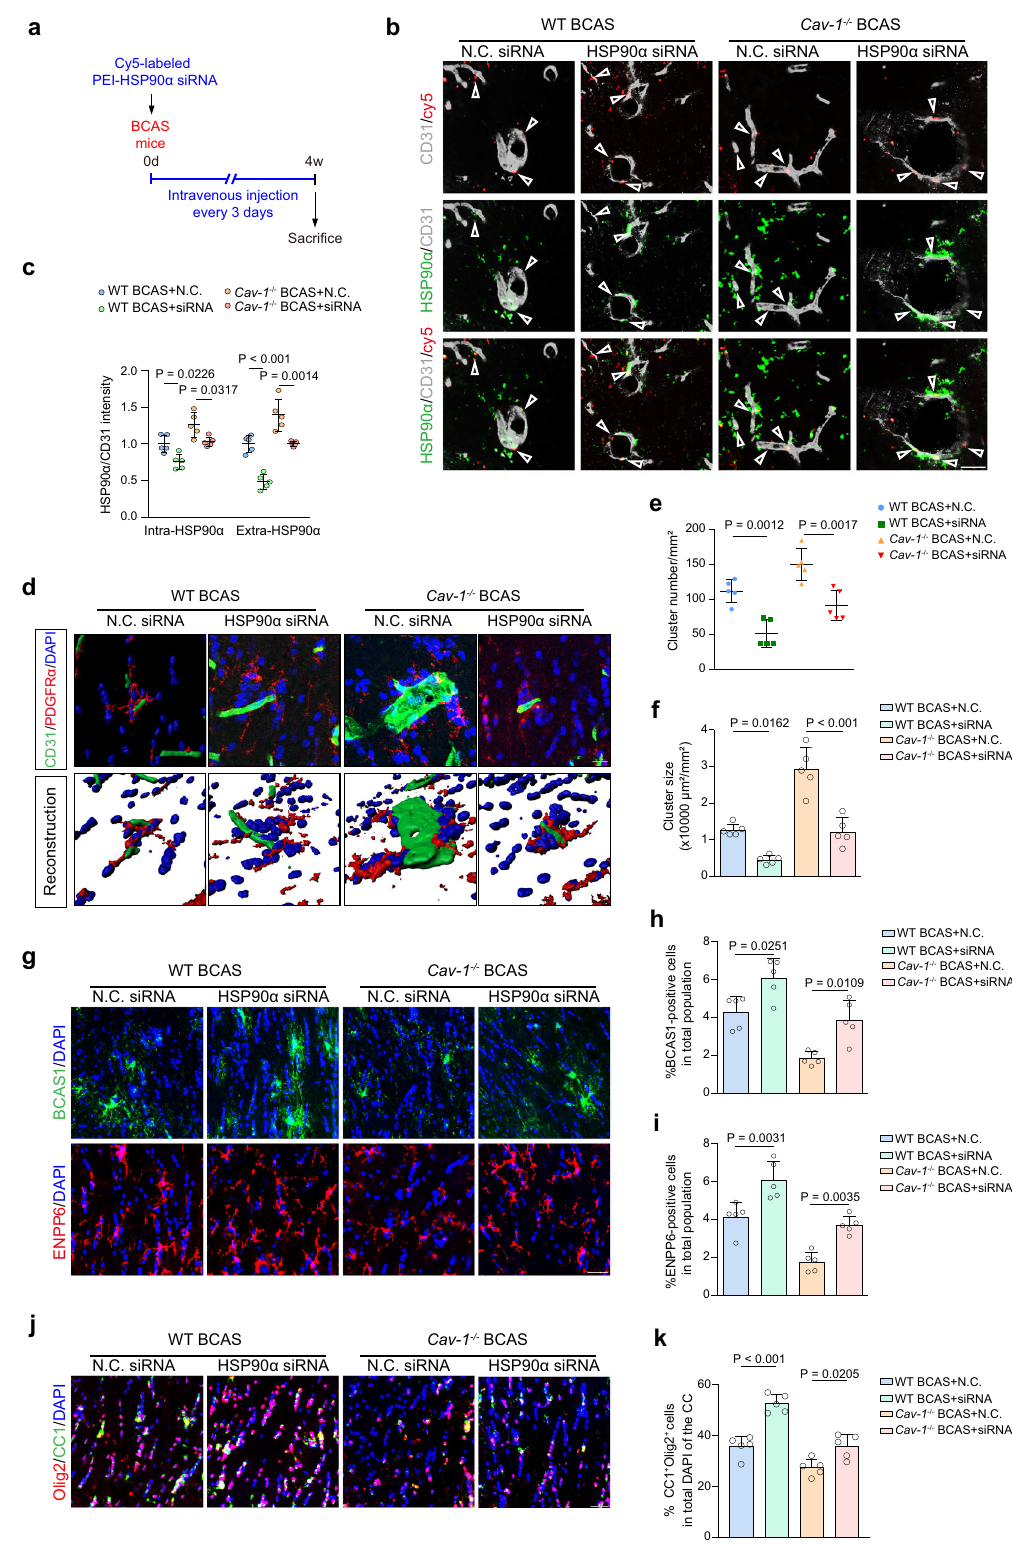
Fig. 5 | HSP90 α siRNA rescues white matter abnormality in wild type and Cav-1 − / − BCAS mice. a Flow chart. b Representative images of Cy5-siRNA (red) uptake in CD31 + vessels (grey) with HSP90 α (green) in the CC of wild type and Cav-1 − / − mice ( n =5 mice/group). Scale bar, 20 μ m. c Quanti fi cation of endothelial and secretoryHSP90 α intensity (normalized to CD31intensity) ( n =5 mice/group). d Representative staining and reconstruction images of PDGFR α + OPC clusters attached on the vessel ( n =5 mice/group). Scale bar, 20 μ m. e , f Quanti fi cation of